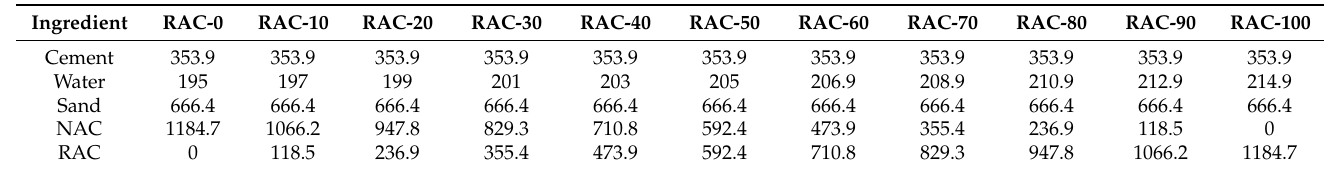
Table 2. Cement mixture design of concrete (kg/m 3